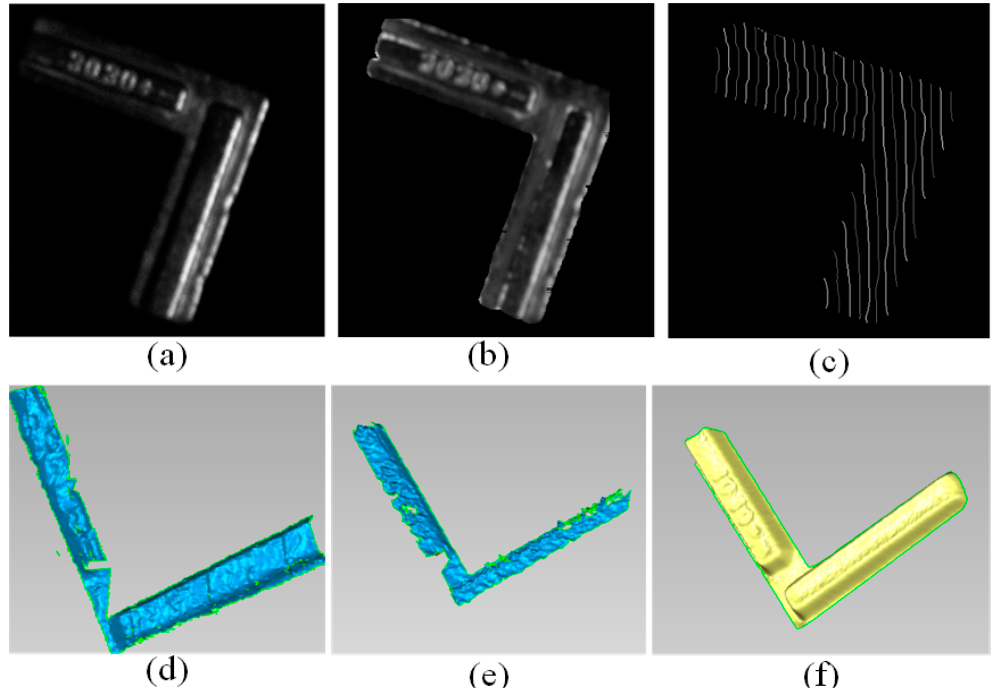
Figure 11. Results and comparisons of a metal object. ( a ) A metal object with specular reflection; ( b ) The restored all-white image based on the estimated reflectance parameters; ( c ) The result of stripe detection by ours; ( d ) The reconstruction result by phase-shifting method in [28]; ( e ) The reconstruction result by [2]; ( f ) The reconstruction result by ours.